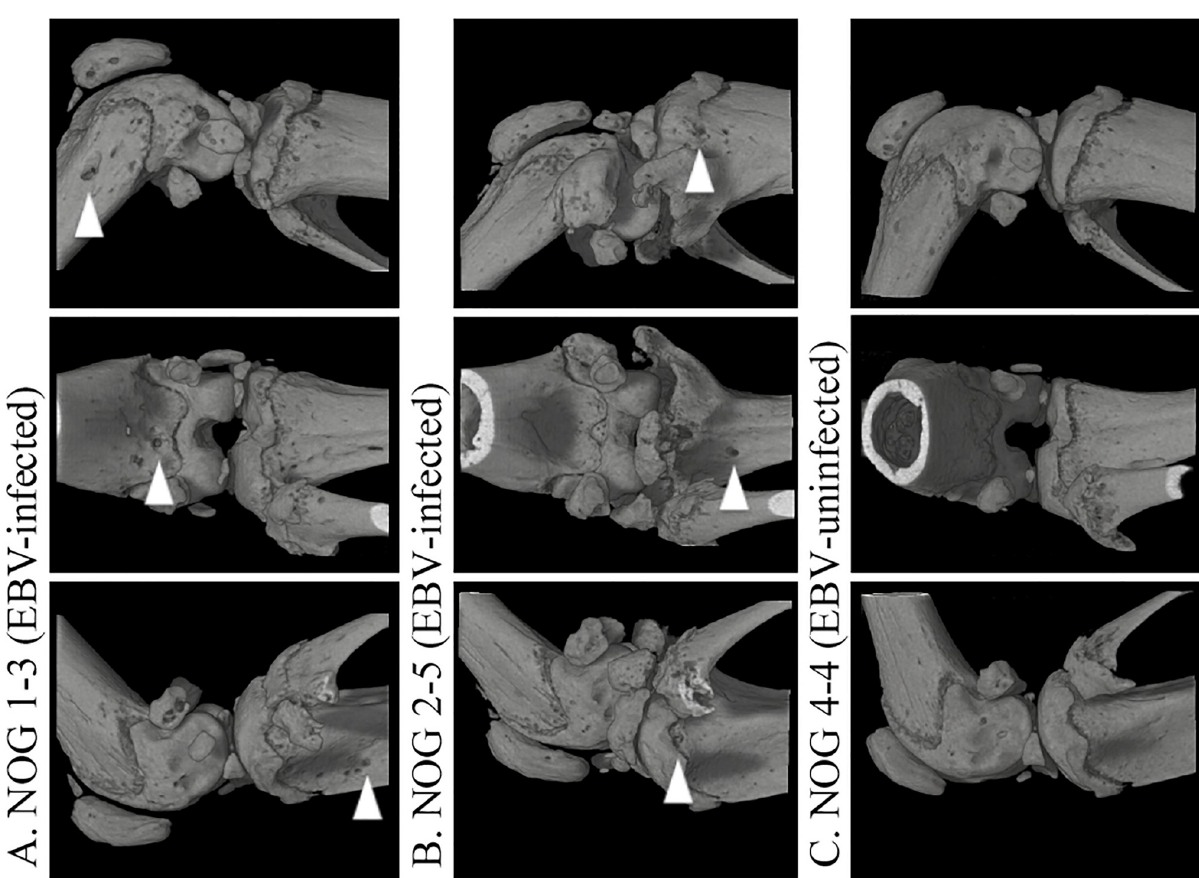
Fig 2. 3D-CT images of knee joints in EBV-infected and -uninfected hu-NOG mice. (A) Joint from an EBV-infected mouse. Arrowheads indicate bone erosion at the distal portion of the femur and proximal portion of the tibia. (B) Joint of another EBV-infected mouse. (C) Joint of an